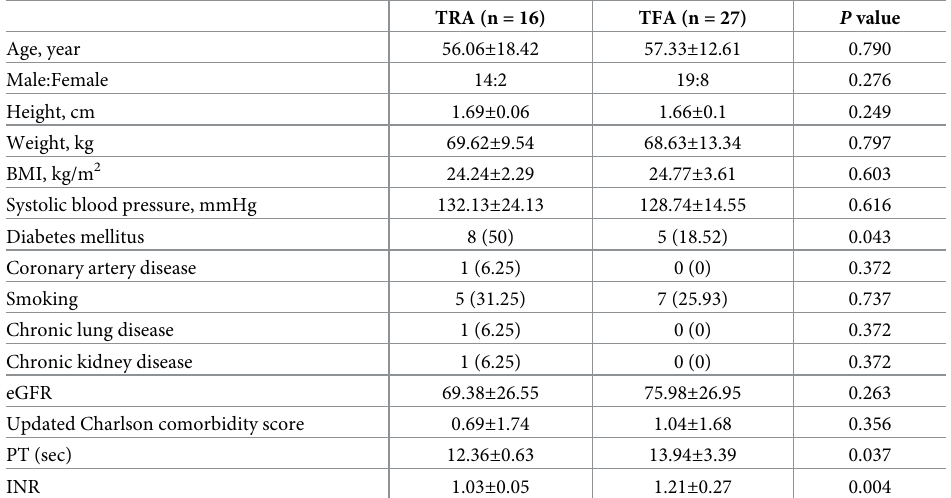
Table 1. Patient demographic characteristics, underlying diseases, comorbidity scores, and coagulation